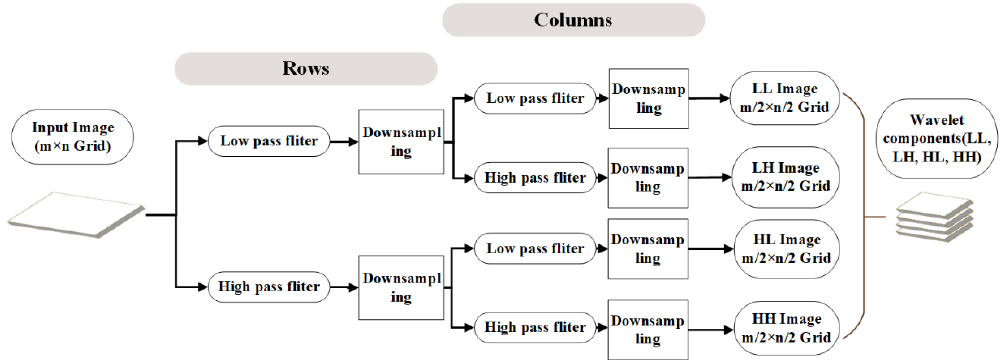
Figure 2. The block diagrams of the wavelet transformation in decomposing an 𝑛 × 𝑚 image into four decomposed images.